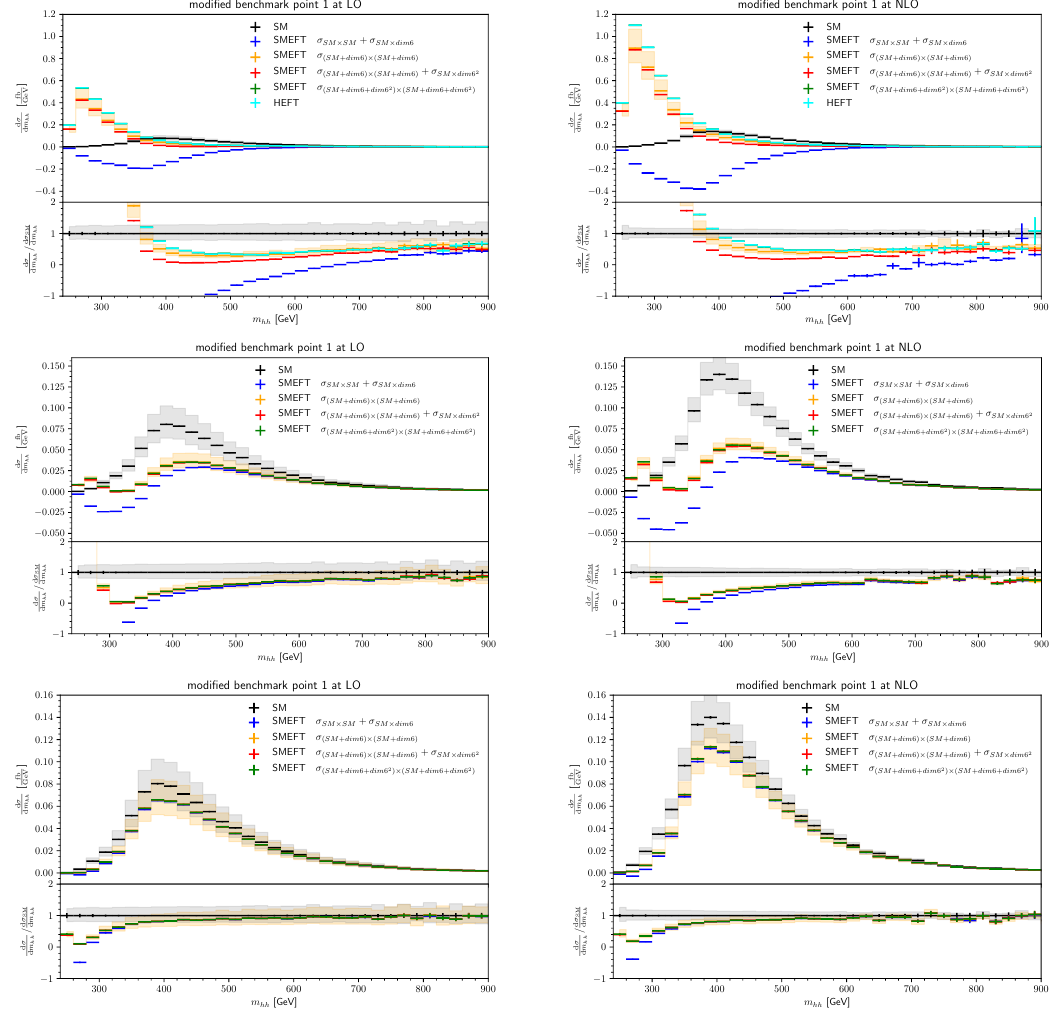
Figure 2 . Differential cross sections for the invariant mass m hh of the Higgs-boson pair for benchmark point 1 of table 2. Top row: Λ = 1 TeV, middle row: Λ = 2 TeV, bottom row: Λ = 4 TeV. Left: LO, right: